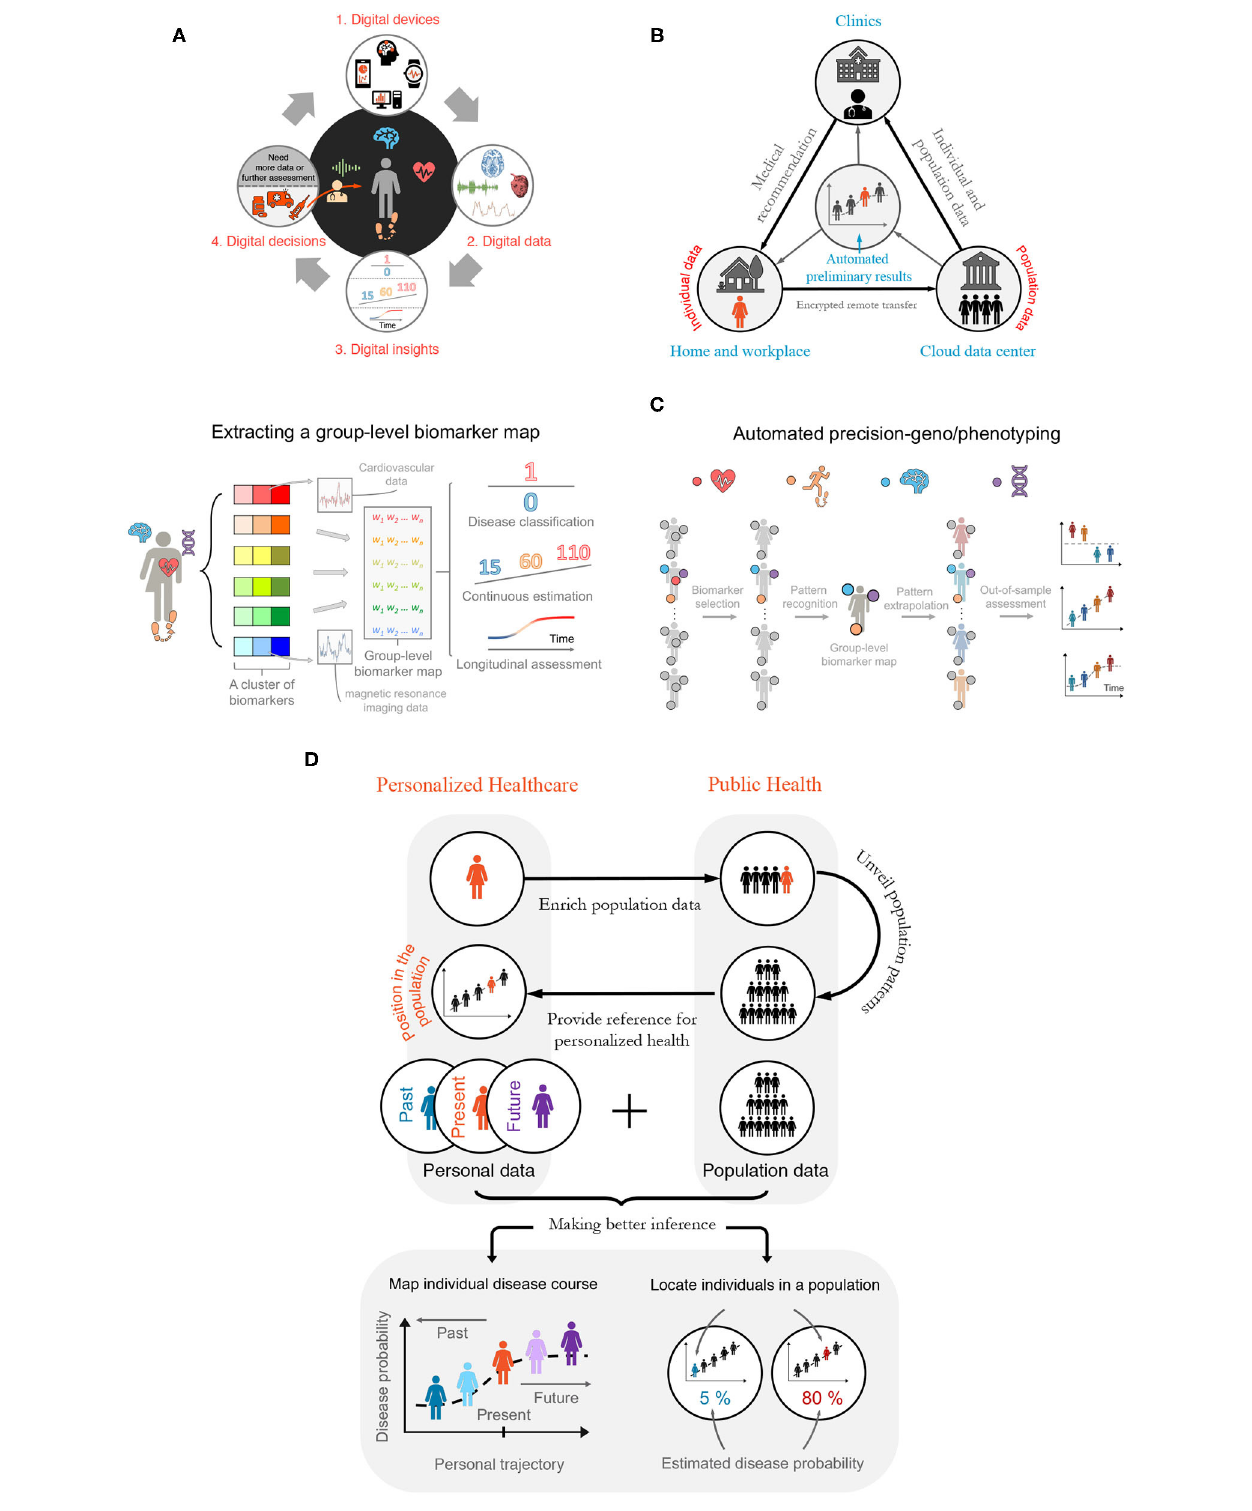
FIGURE 1 | Building a Digitalized Ecosystem. (A) Digitalization cycle—bridging digital health, data, and digitally enabled decision-making. From 1 to 2: Phenotypic information is recorded by, and made available on, digital devices. From 2 to 4 via 3: Advanced modeling and analyses are applied on digital data to guide